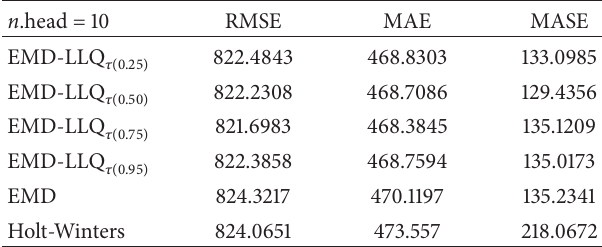
Table 1: Comparison of RMSE, MA, and MASE values for KLSE using the Holt-Winter, LLQ, EMD, and EMD-LLQ methods.